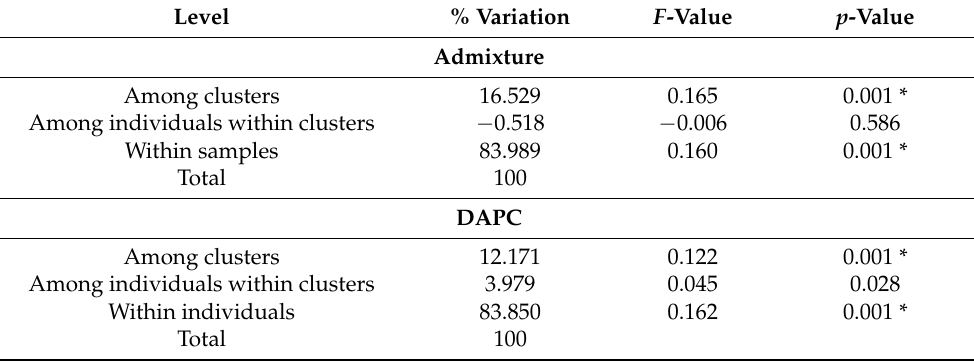
Table 3. Analysis of molecular variance (AMOVA) for 67 C. pubescens samples from the three inferred clusters ( K = 3) using 1462 unlinked biallelic